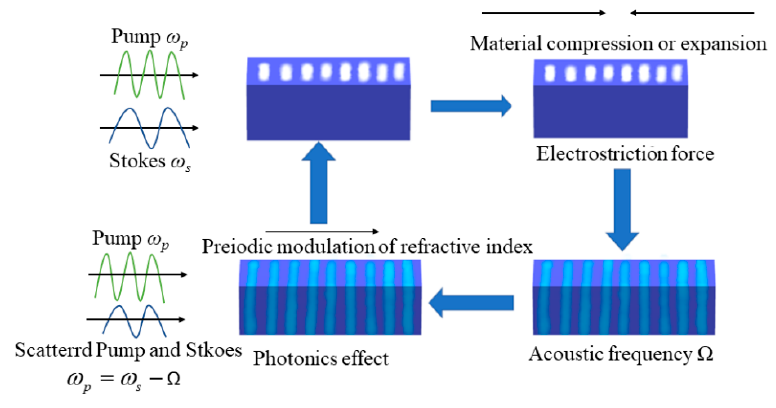
Figure 1. FSBS effect in the waveguide.